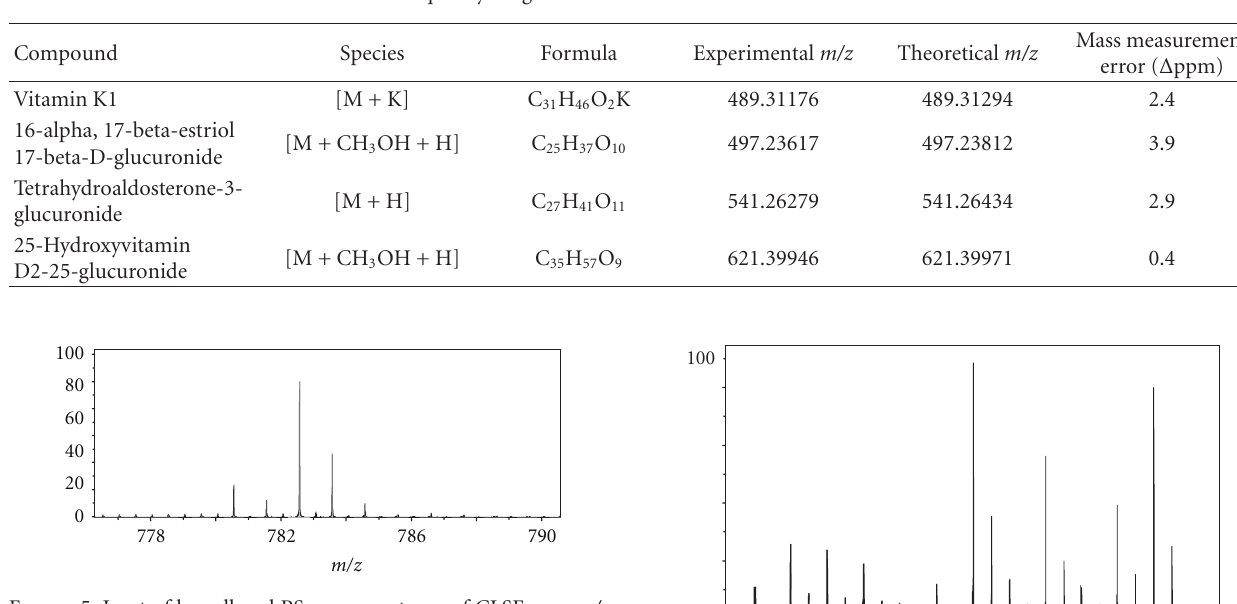
Figure 5: Inset of broadband PS mass spectrum of CLSE over m/z